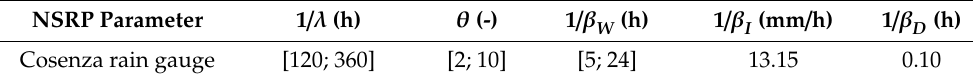
Table 6. NSRP parameters for Cosenza rain gauge derived from EV1 parameters in Table 5.